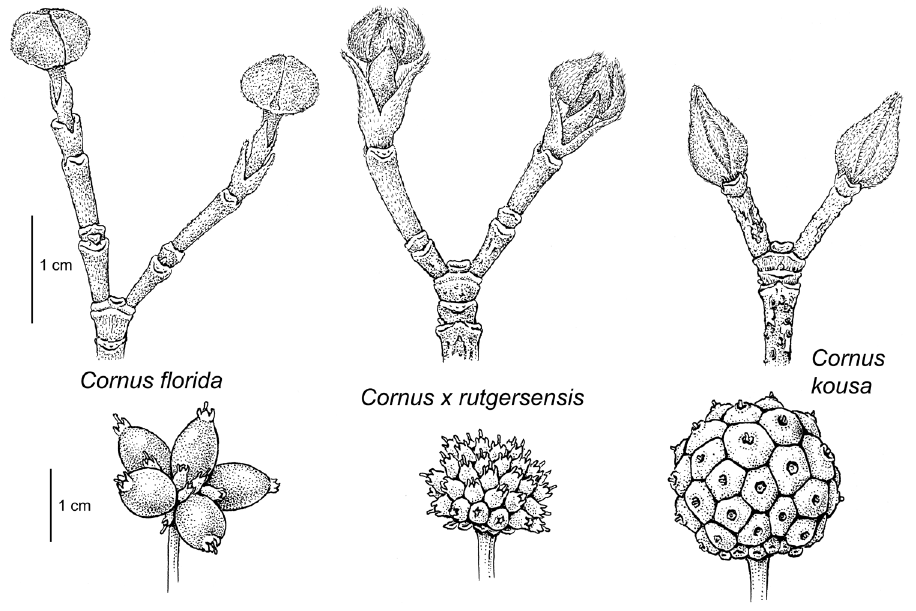
Figure 5. Comparison of flowering bud and fruit development in Cornus florida , Cornus × rutgersensis , and Cornus kousa . Drawing by Bobbi